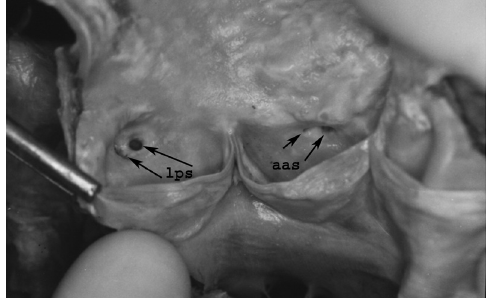
Figure 2 - Multiple ostia (arrows) in the anterior aortic sinus (aas). The left posterior sinus (lps) shows separate ostia (arrows) for the left anterior descending and the left circumflex